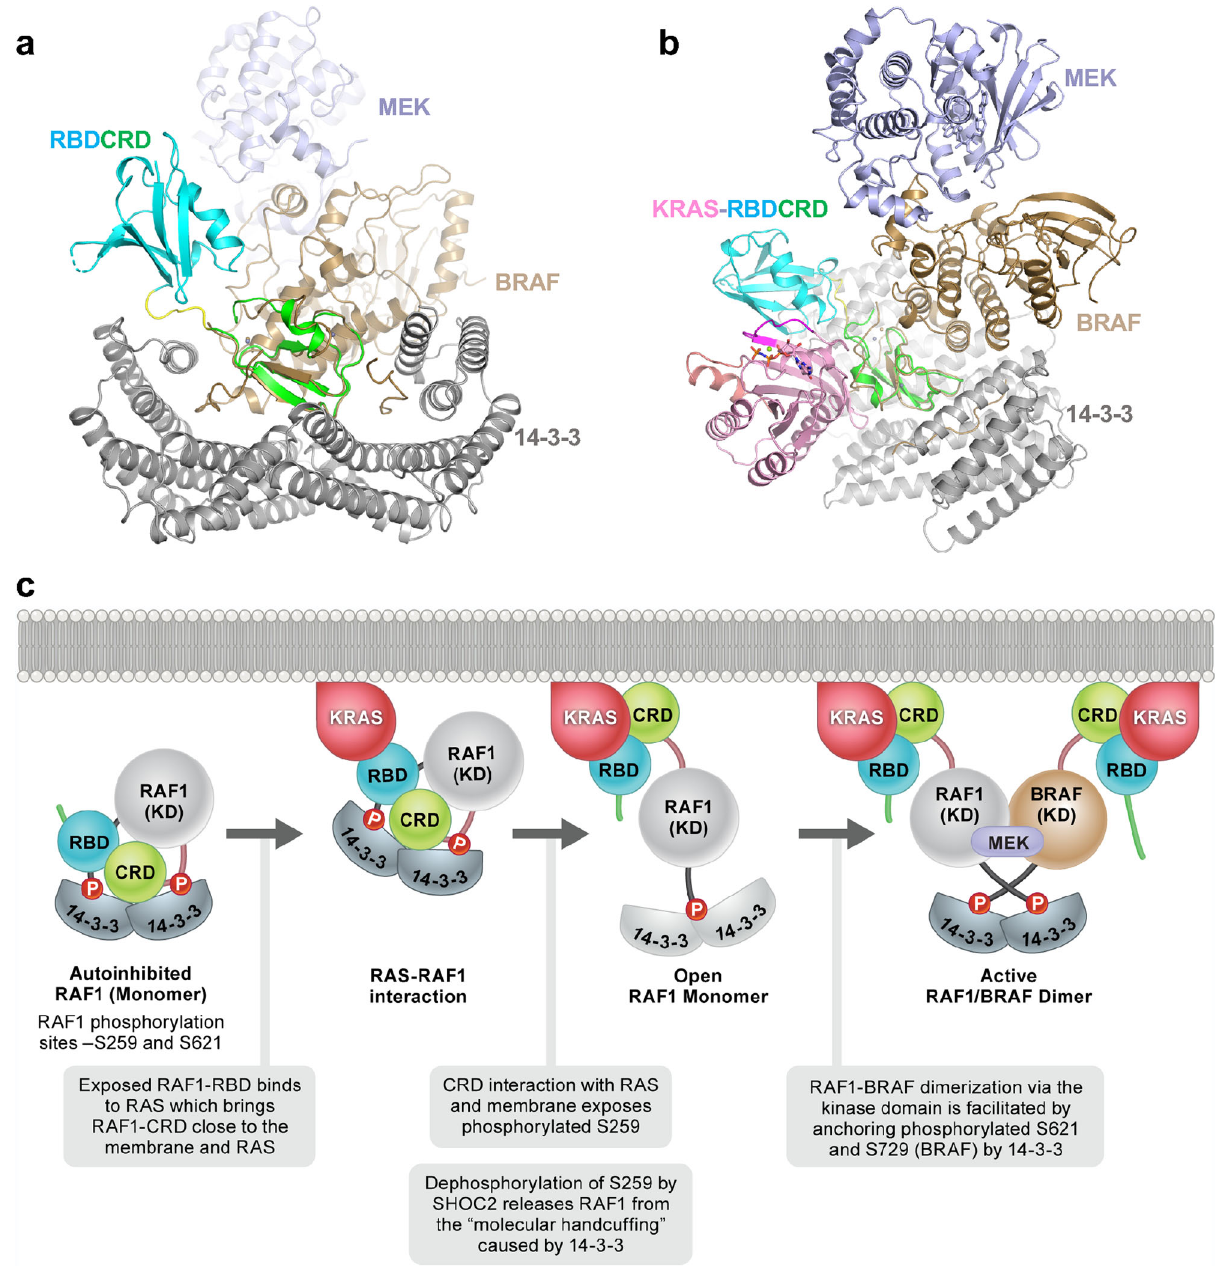
Fig. 8 Model of RAS-mediated RAF activation using structural insights obtained from KRAS-RBDCRD and MEK-BRAF-14-3-3 structures. a Structural superposition of KRAS-RBDCRD and the cryoEM structure of MEK-BRAF-14-3-3 (PDB 6NYB). Structures were aligned by their CRD domains. KRAS is hidden in this panel in order to show the alignment of CRD and the placement of RBD clearly. RAF1(RBDCRD) has the same color-coding scheme as used in Fig. 1c, while MEK, BRAF, and 14-3-3 are colored light blue, brown, and gray, respectively. b Same as a but at a different angle. KRAS is shown to illustrate it has minimal contacts with 14-3-3 in our structural alignment based on CRD. c Schematic diagram showing KRAS fi rst interacts with autoinhibited RAF via RBD and then CRD to bring RAF close to the membrane. This results in CRD coming out of the autoinhibited conformation and interacting with the membrane and KRAS, and in turn exposing the phosphorylated serine present in the CR2 region. Dephosphorylation of S259 (RAF1) by SHOC2 complex results in an active RAF1 monomer, where 14-3-3 binds to only one phosphorylated serine located at the C-terminal end. Homo-dimerization or hetero- dimerization of KRAS-RAF1 with an active RAF monomer containing either RAF1 or BRAF results in the formation of an active dimerized RAF complex. RAF1 has been shown to prefer hetero-dimerization with BRAF which is bound to MEK for initiating the activation